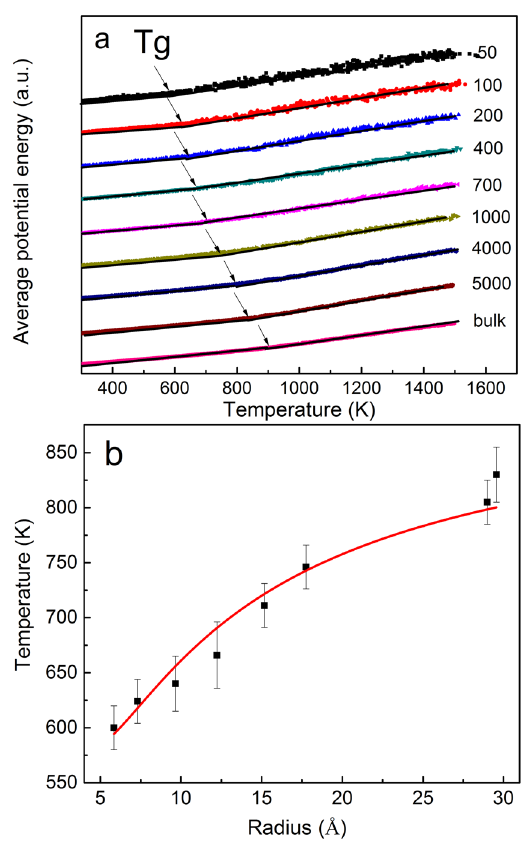
Figure 6. ( a ) Determination of glass transition temperature T g via an intersection of low- and high-temperature dependences of the potential energy in Cu 64 Zr 36 SSAPs with different sizes and bulk Cu 64 Zr 36 MG. ( b ) The sample-size dependent T g of Cu 64 Zr 36 SSAPs with different sizes together with the fitting curve, which is explained in